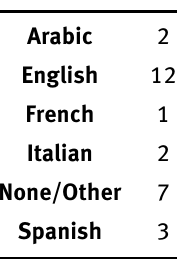
Table 4: Other languages spoken by participants.